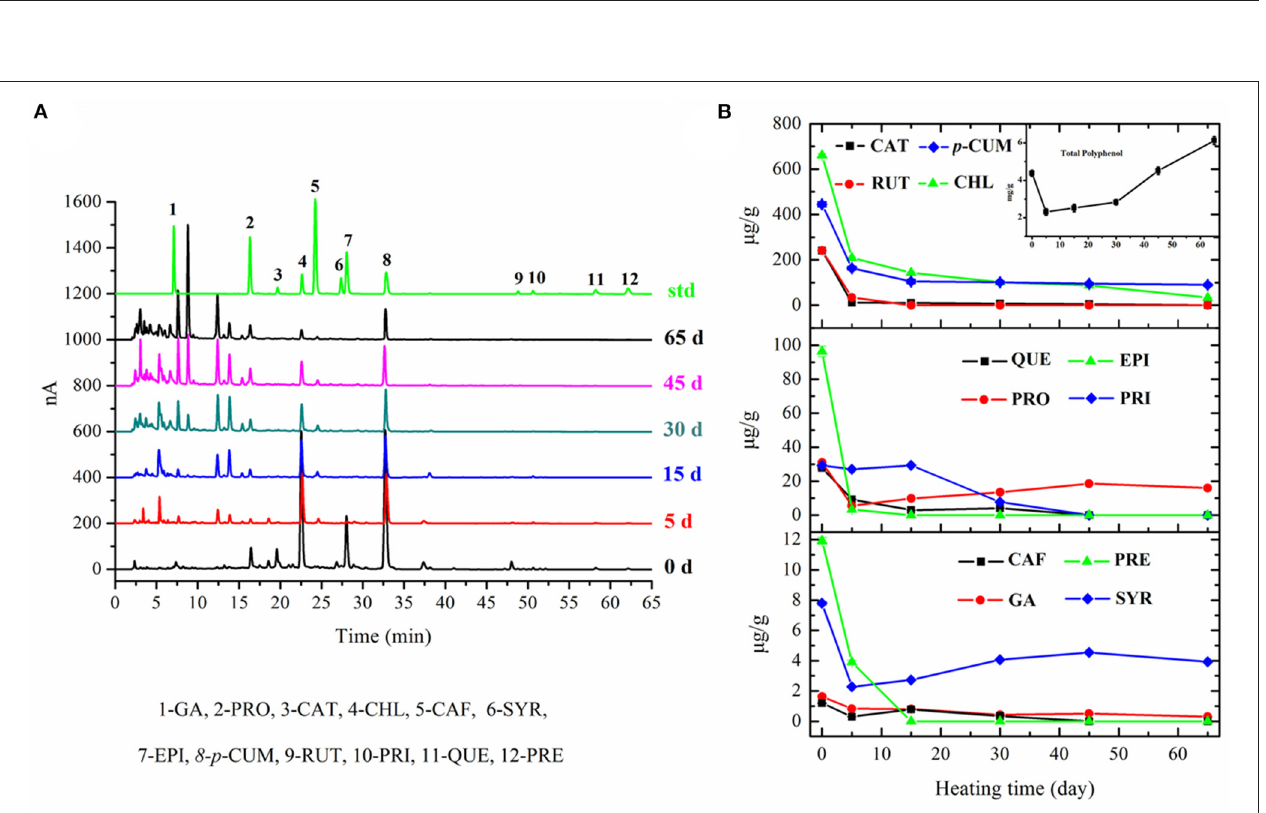
FIGURE 4 | Chromatograms of polyphenols in apple samples with different fermentation days (A) and changes in TPC (inset) and polyphenolic profiles of apple during 65-day HTFP process (B) .